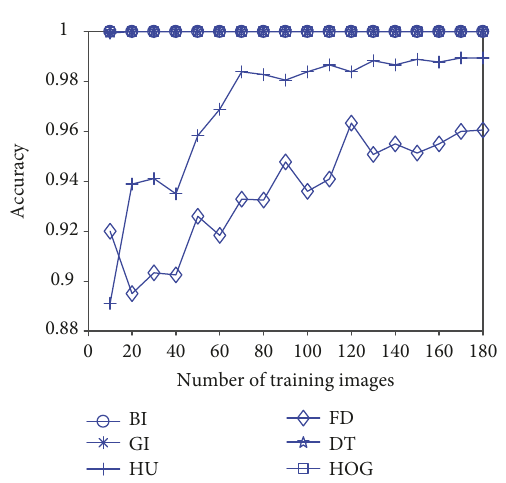
Figure 10: Satellite recognition performance on sparse training